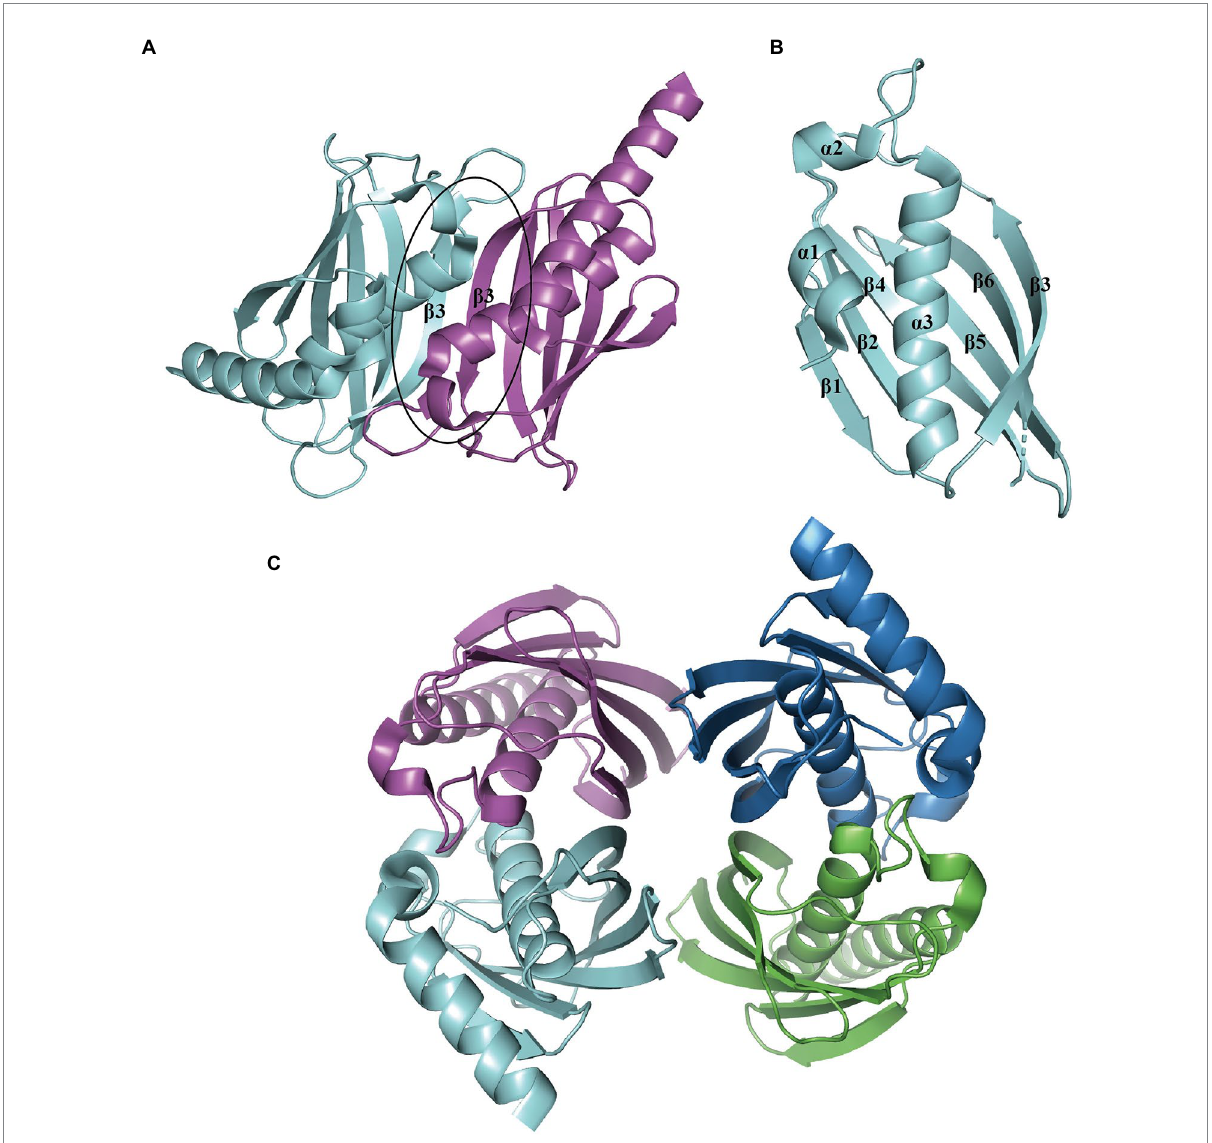
FIGURE 7 Overall structure of PaaI. (A) The PaaI reveals a hotdog fold shape with a core α -helix ( α 3) enveloped by a six-strand β -sheet ( β 1- β 6). (B) The architecture unit PaaI dimer is formed by the interaction between β -sheets in each monomer. (C) The overall structure of tetramer TthPaaI (PDB:1J1Y) is shown in different colors for each